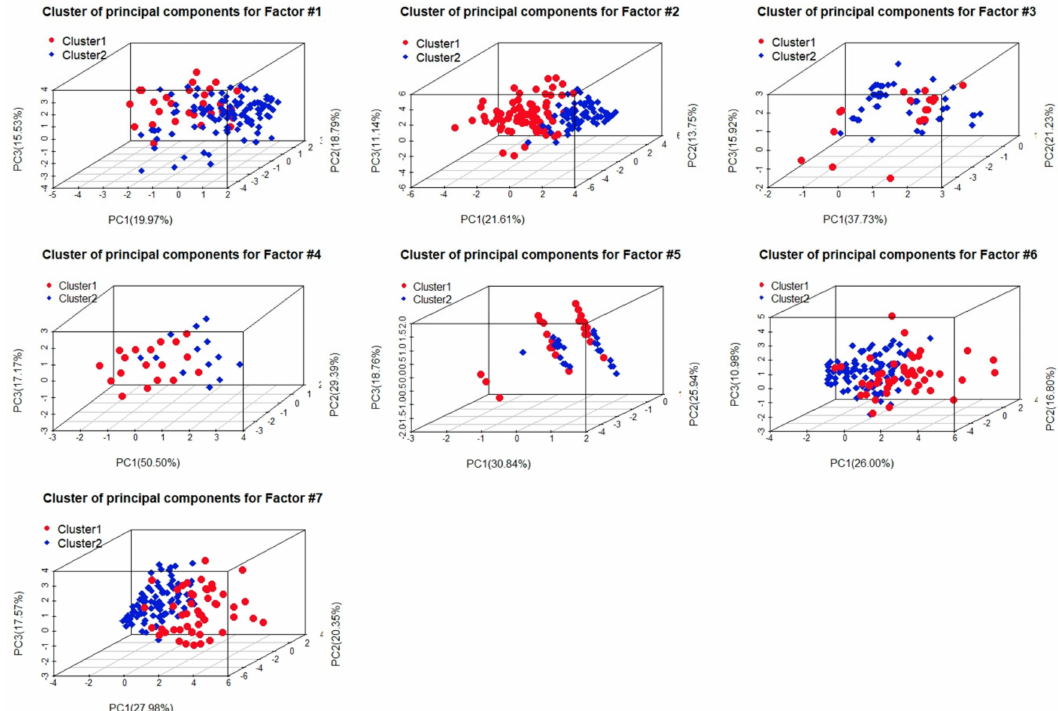
Figure 9. Clusters based on membership in basin (red circles) or non-basin (blue diamonds) states. Where factor—#1 is geography, hydrology, ecology, and natural features, factor-#2 is socio-economic needs of basin states, factor-#3 is the population dependent on the watercourse, factor-#4 is the e ff ects of water use, factor-#5 is existing and potential uses, factor-#6 is costs of conservation and protection, and factor-#7 is availability of alternative and comparable values and